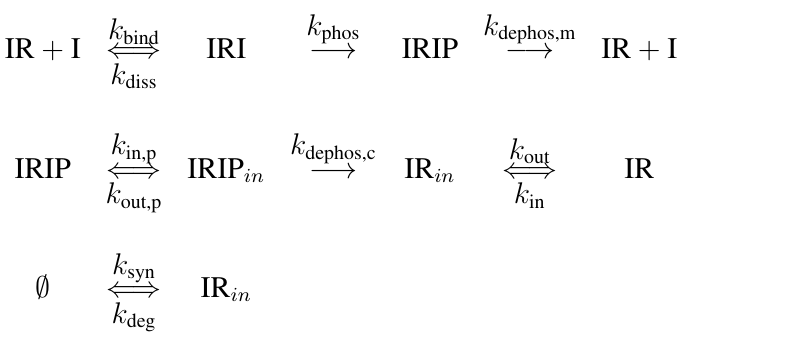
Table 1. List of abbreviations and initial concentrations. Initial concentrations are adopted from Sedaghat et al. [34]. The concentrations are given in units of pM = 10 − 12